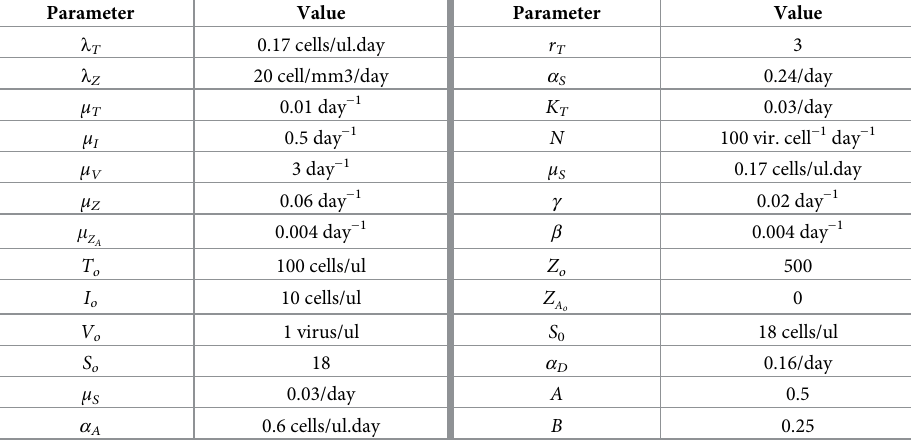
Table 2. The value of the parameters based on a realistic analysis